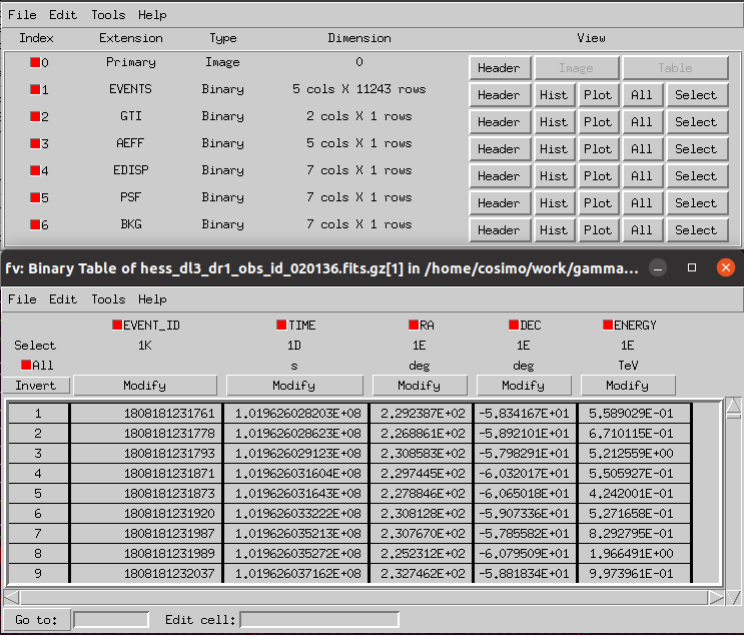
Figure 3. Example of a DL3 file compliant with the GADF specifications. Top: the header data units (or extensions) of the file contain the event lists, under ( EVENTS ), followed by those representing the good time intervals ( GTI ) and the instrument response components: effective area ( AEFF ), energy dispersion ( EDISP ), point spread function ( PSF ) and background ( BKG ). Bottom: event list table and its